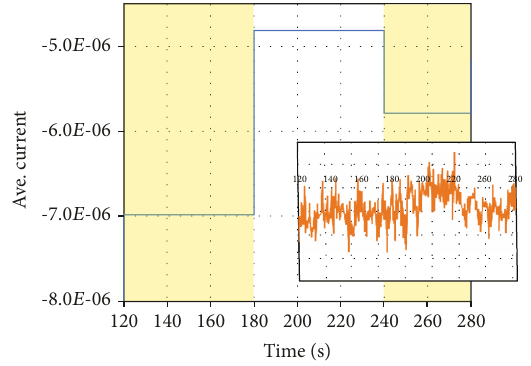
Figure 4: Photoresponse of the 30V RT 125 ° C sample biased -0.5 V vs. Ag/AgCl during chopped-light